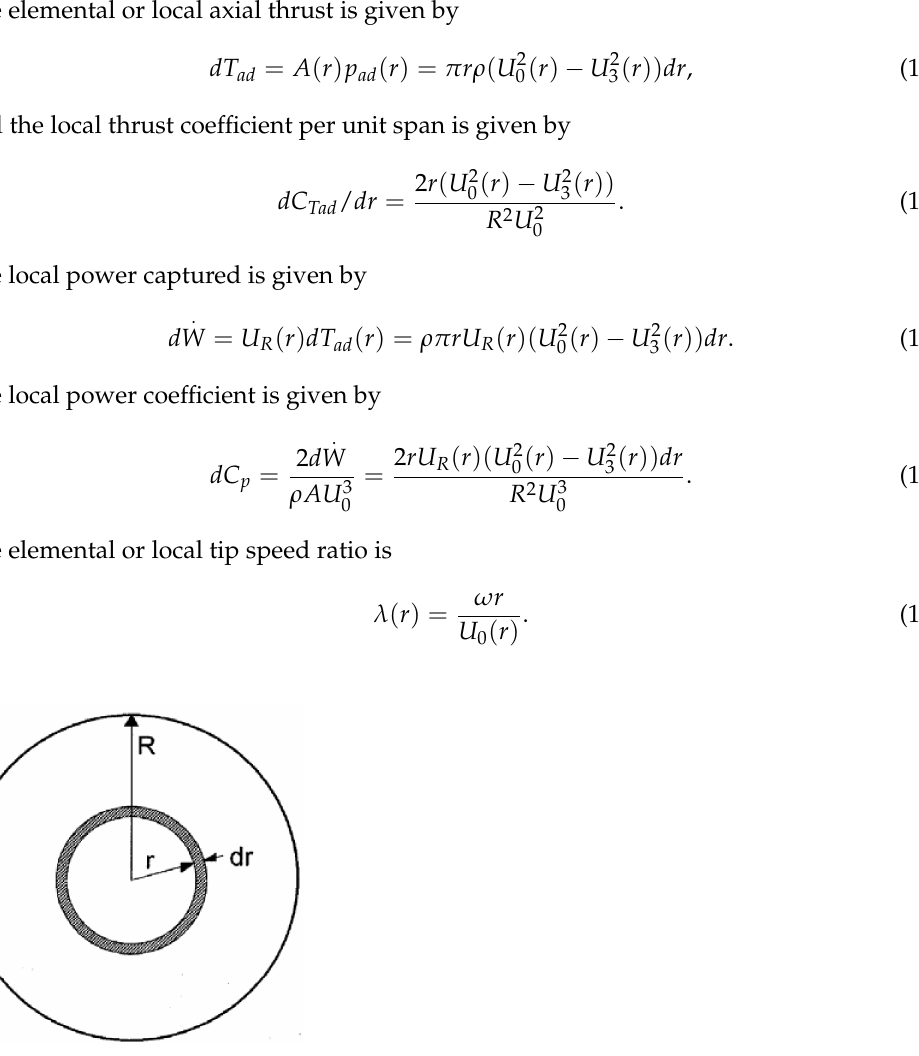
Figure 1. Cross-section of the actuator